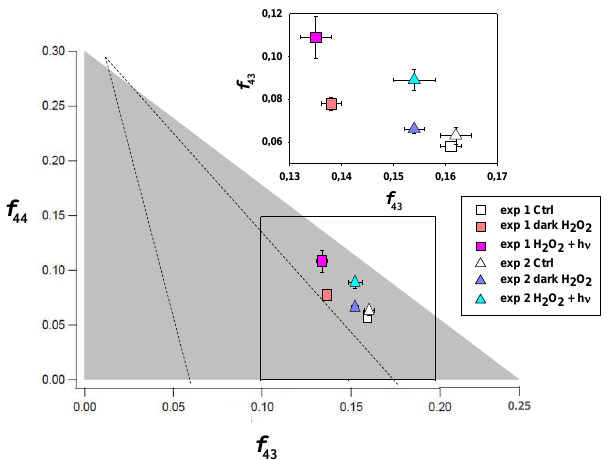
Fig. 2. f 44 versus f 43 for LV-OOA and SV-OOA components from Figure 2 : f 44 versus f 43 for LV-OOA and SV-OOA components from a compilation of 19 a compilation of ambient air data (dotted line area) (Ng et al., 2010) ambient air data (dotted line area) (Ng et al., 2010) and simulation chamber data (grey area) 20 and simulation chamber data (grey area) (Lee et al., 2011), and from (Lee et al., 2011), and from the two isoprene experiments measured in this work (and the 21 the two isoprene experiments measured in this work (and the cor- corresponding zoom). Error bars represent the standard deviation for the first 44 minutes of 22 responding zoom). Error bars represent the standard deviation for nebulization for “control” samples (Ctrl), “dark H 2 O 2 ” samples, and “H 2 O 2 + h  ” samples. 23 the first 44min of nebulization for “control” samples (Ctrl), “dark 24 H 2 O 2 ” samples, and “H 2 O 2 + hν ”